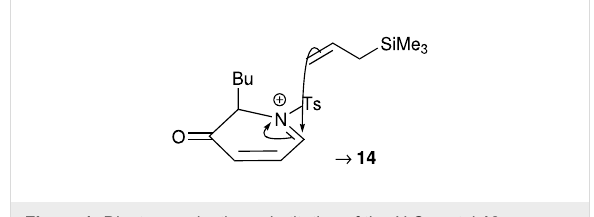
Figure 1: Diastereoselective substitution of the N,O acetal 12